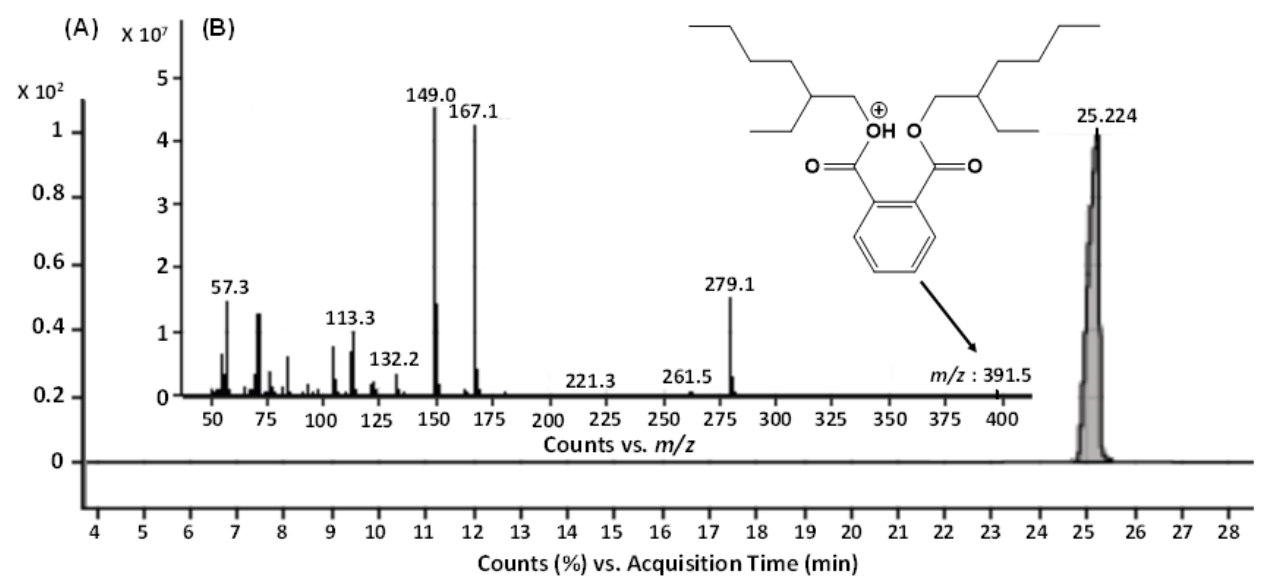
Figure 4. GC-MS analysis of the bioactive fraction (F2) of ethyl acetate crude extract from L. plantarum BCH-1. ( A ) Total Ion Chromatogram (TIC) of F2 fraction ( B ) Mass spectrum of ion peak at 25.224 min.